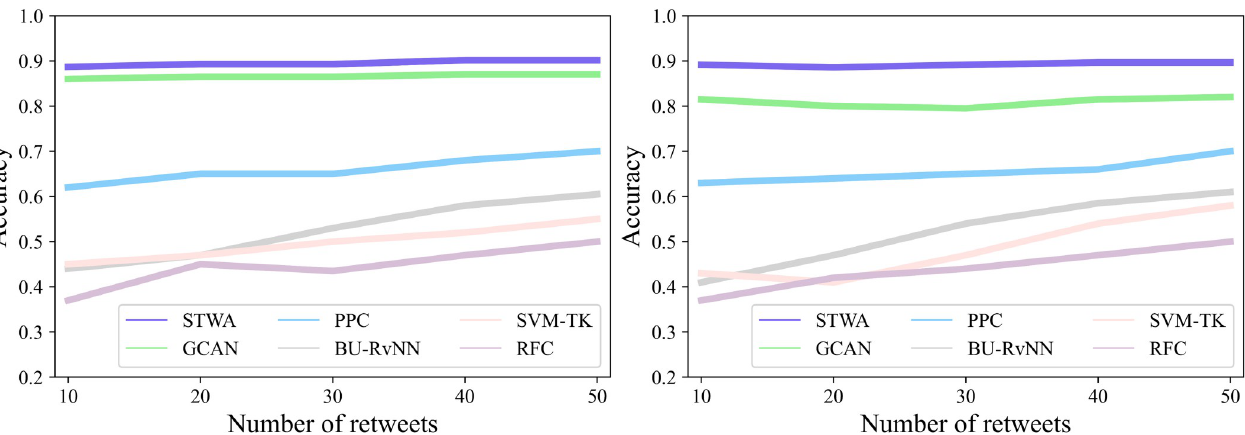
PLOS ONE | https://doi.org/10.1371/journal.pone.0271224 July 11,